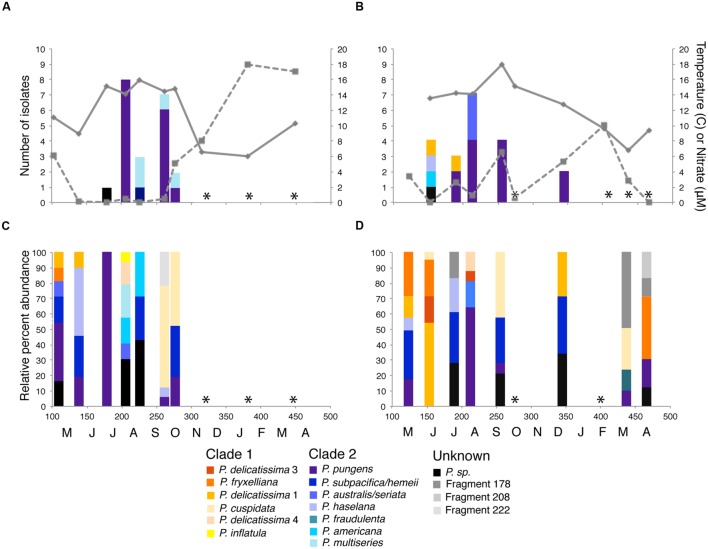
Pseudo-nitzschia isolates obtained and community composition at (A,C) Penn Cove and (B,D) Grays Harbor from April 2013 to April 2014. Time of sampling is shown in Julian day and monthly increments on the x-axis. Solid lines are water temperature and dashed lines are nitrate concentration. Pseudo-nitzschia species are colored by phylogenetic clade (Lundholm et al., 2002, Guannel, unpublished data) with members of clade 1 represented by warm colors and clade 2 represented by cool colors. Unidentifiable ARISA fragments are represented in grayscale. Black bars represent ARISA fragments for isolated Pseudo-nitzschia with no species identification. ∗ indicates months with no detectable Pseudo-nitzschia by ARISA or in net tows.